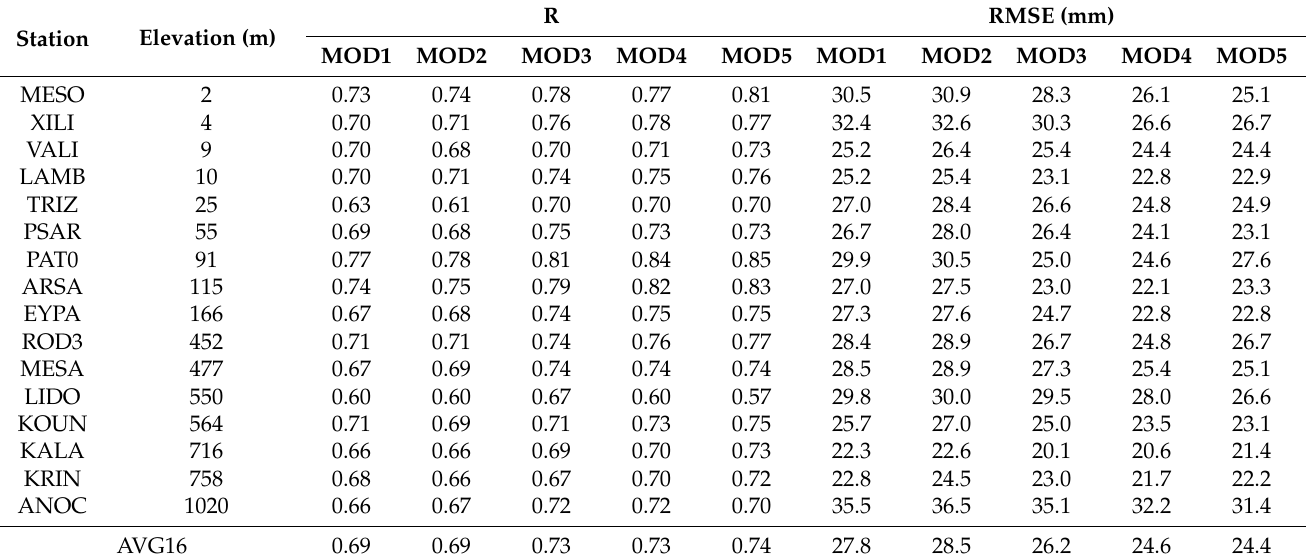
Table 3. Pearson Correlation Co-efficient and RMSE results for all schemes (17/6–29/6/2016).